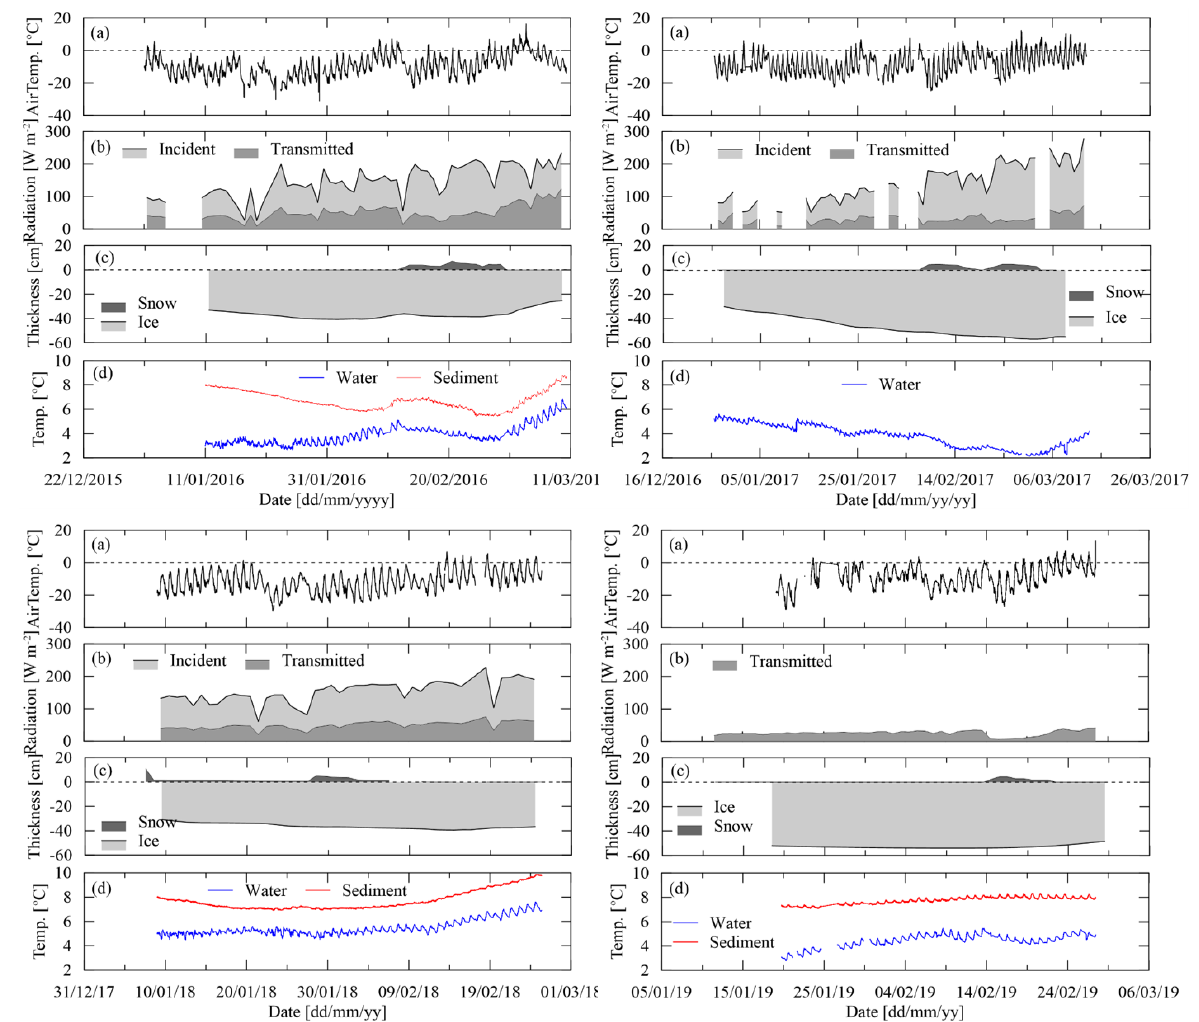
Figure 4. Observational air temperature T a (a) , daily means of incident and transmitted solar radiation (b) , snow and ice thickness (c) , temperature of the water column and surface sediment (d) . (Top left: winter 2016; top right: winter 2017; bottom left: winter 2018; bottom right: winter